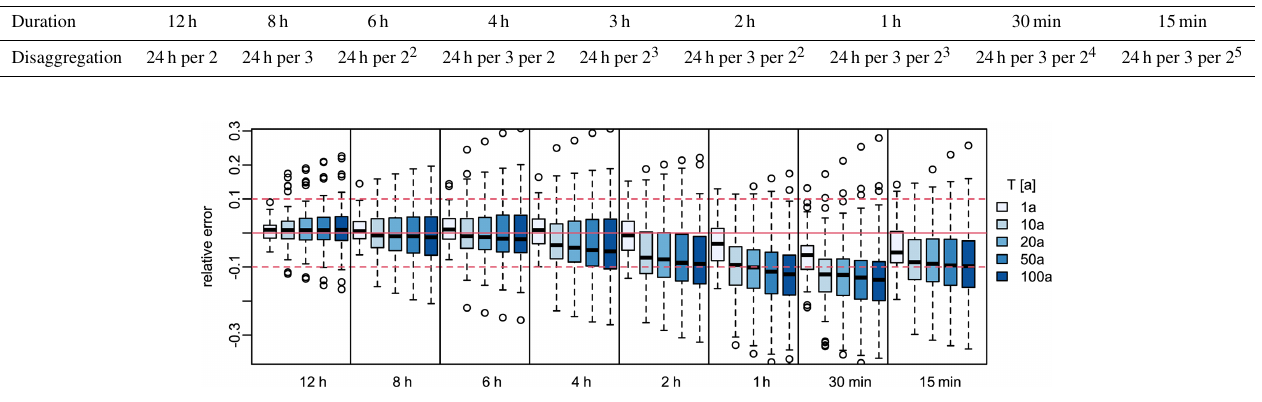
Figure 3. The relative error ( − ) of the disaggregated daily station data (30 realisations) based on radar parameterisation for different return periods and duration levels: ( + ) sign indicates overestimation, while ( − ) sign is the underestimation of extremes. Different blue shades indicate the error at different return periods (in years) as shown in the legend (eg. 1a is a 1-year return period).